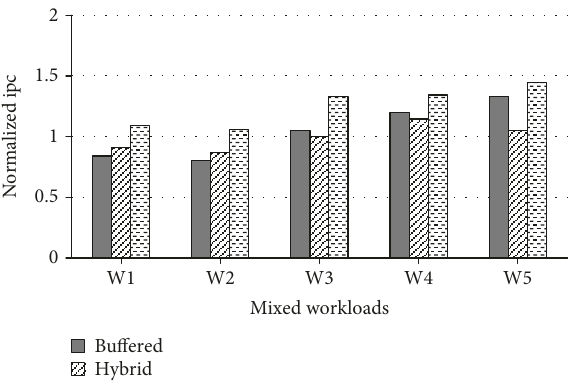
Figure 11: Normalized de fl ection rate of the hybrid loads with 64 threads.